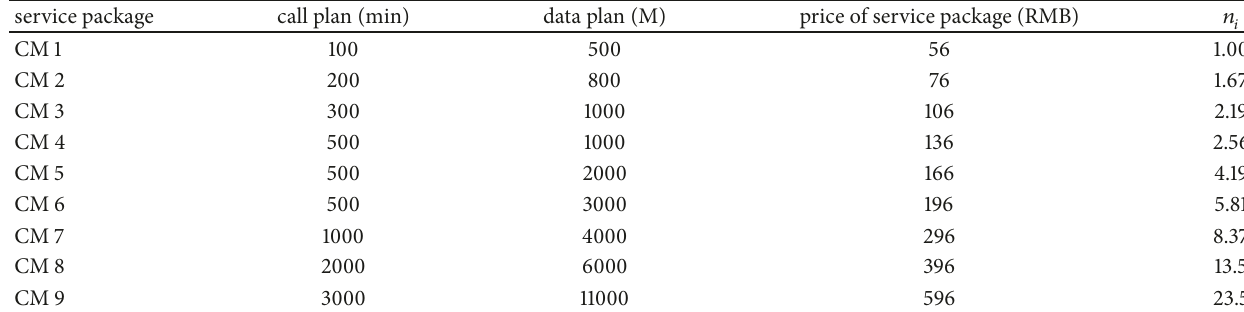
Table 2: The price list of CUCC.